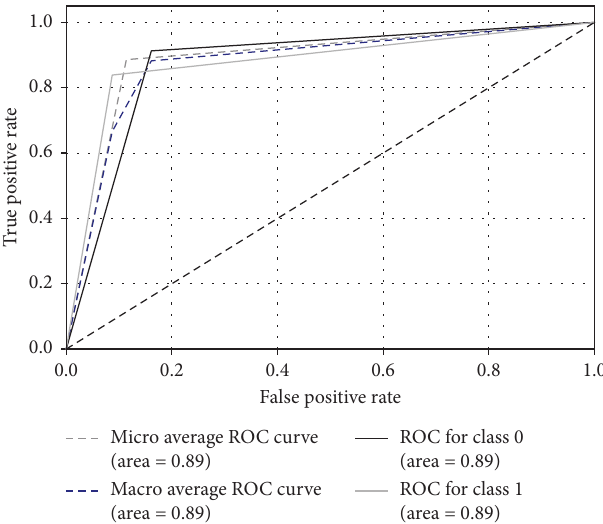
Figure 9: ROC curve for testing data using RF model.